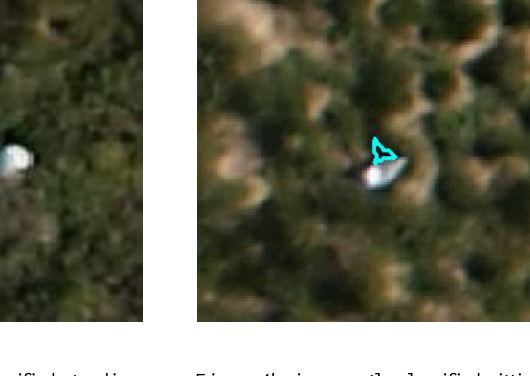
Figure 4b. incorrectly classified sitting bird (adjacent vegetation)